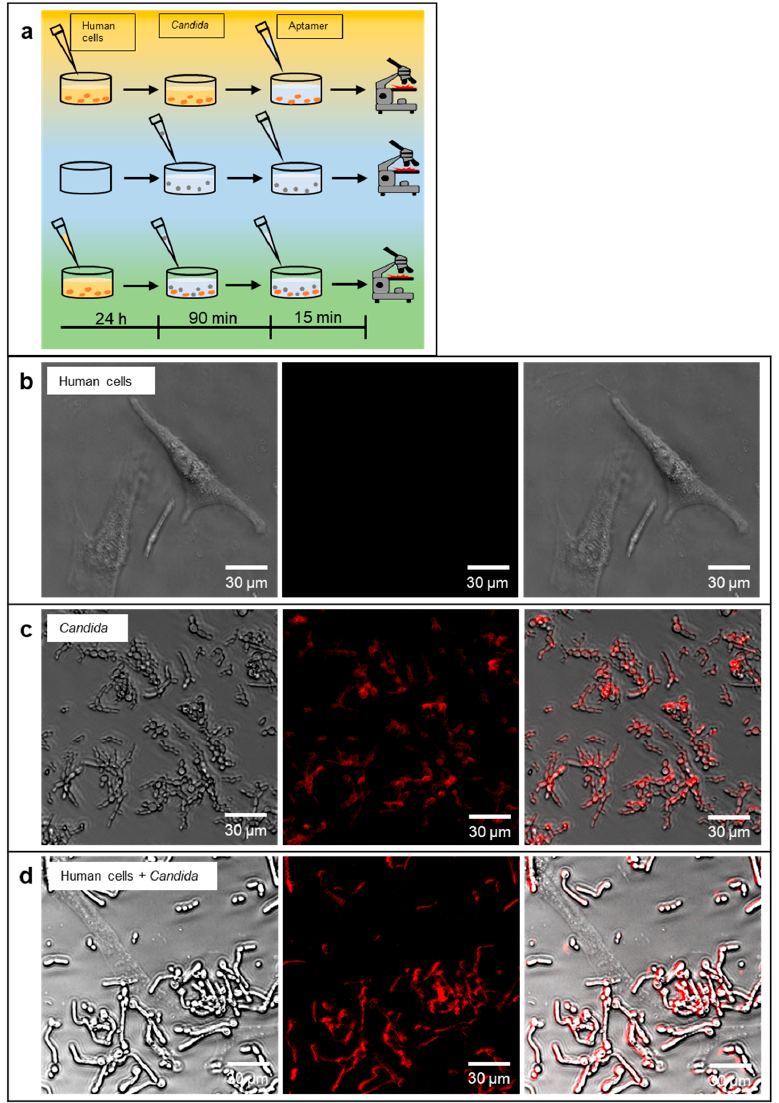
Figure 3. Specific labeling of mixed Candida cells by the SELEX-derived aptamer library R8. ( a ) Experimental set-up of the microscopic differentiation analyses for Candida and human cells (HDF). Incubation of single cells individually and as a mixture together with aptamer. ( b ) Microscopic images of human cells with aptamer as the negative control (transmitted light, fluorescence, merge). ( c ) Candida alone as the positive control. ( d ) Fluorescence micrographs of a mixture of human cells “infected” with Candida. Candida cells were allowed to bind to the substratum of the cell culture flask including the human cells for 90 min prior the analysis.